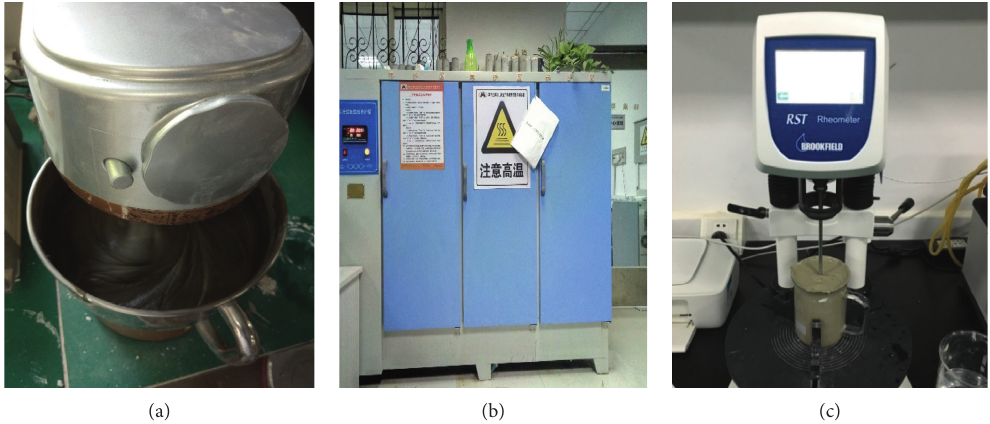
Figure 6: The preparation stages of CPB samples: (a) mixing, (b) curing, and (c)